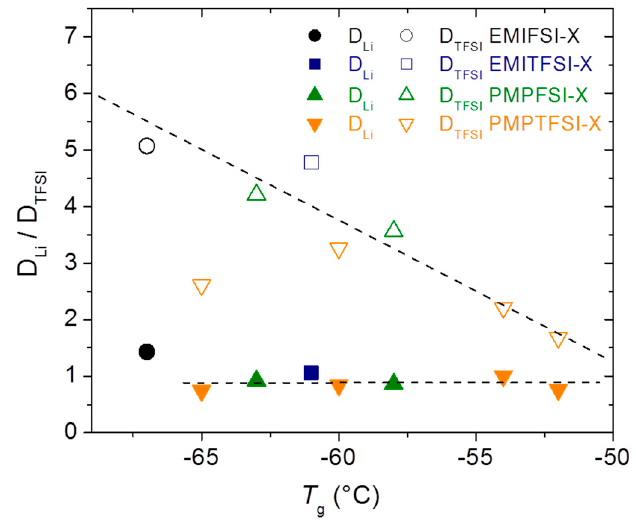
Figure 8. Variation of D Li and D TFSI as a function of the electrolytes’ T g .